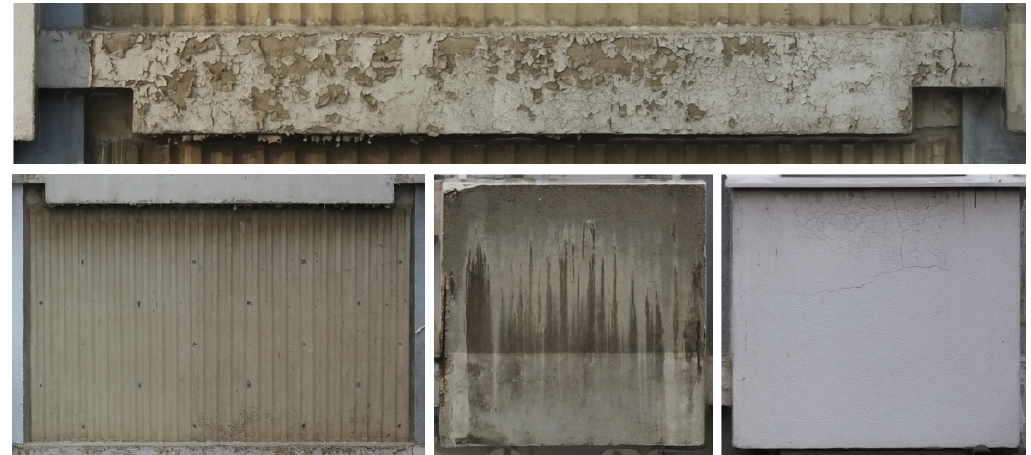
Figure 5. Realistic and clear presentation of façade elements on the generated orthofaçade image.